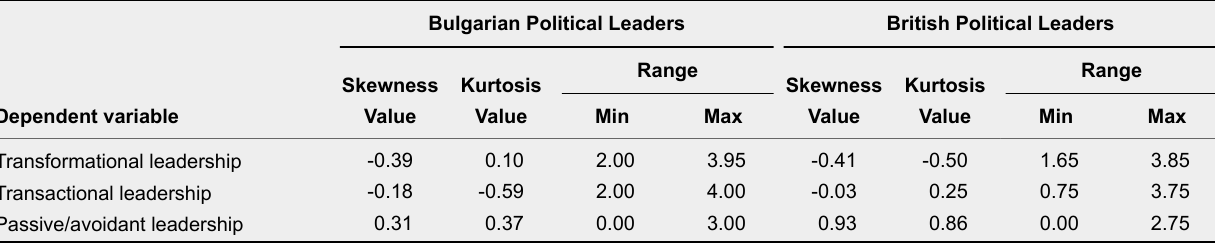
Ranges and Skewness and Kurtosis Values for the Three MLQ Leadership Style Frequency Scores for Bulgarian (N = 63) and British (N = 77) Political Leaders